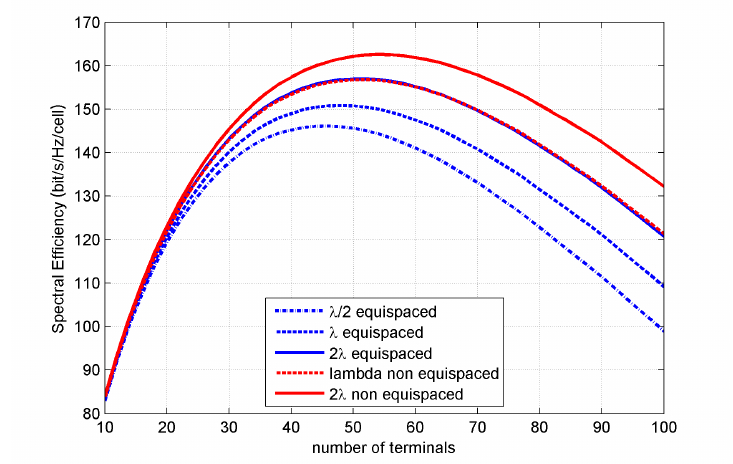
Figure 20. Average maximum achievable Zero Forcing (ZF) rate as a function of the number of user terminals K